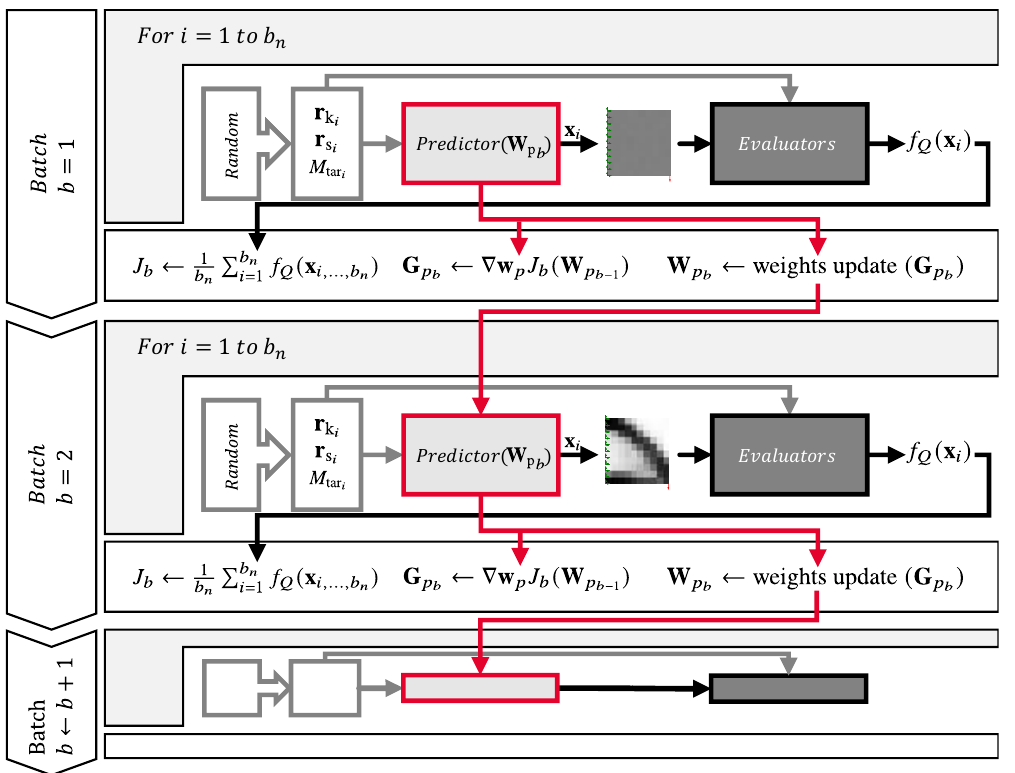
Figure 9. Training process of the predictor–evaluator network (PEN).